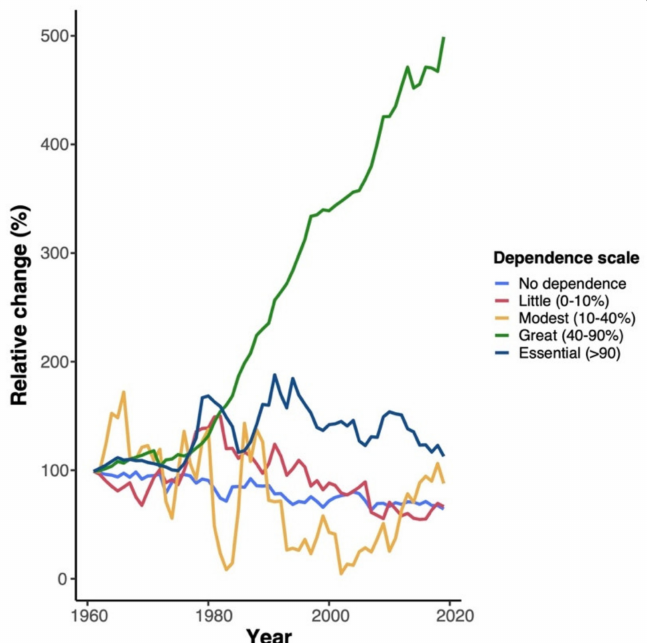
Figure 1. Relative change (expressed as %) in pollinator-dependent crops in Chile between 1960 and 2020. Crop area was retrieved from FAOSTATS [15] and classified in five pollinator dependency categories following Klein et al.